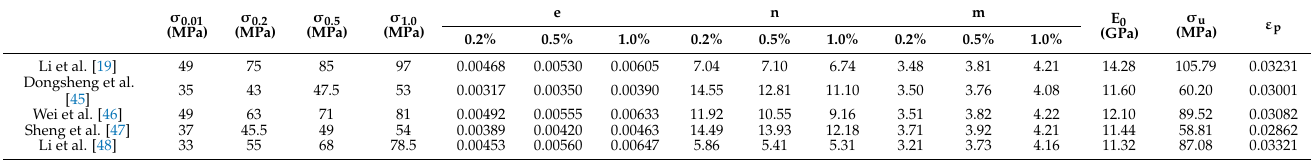
Table 5. Key material properties of bamboo scrimber based on the reported experimental